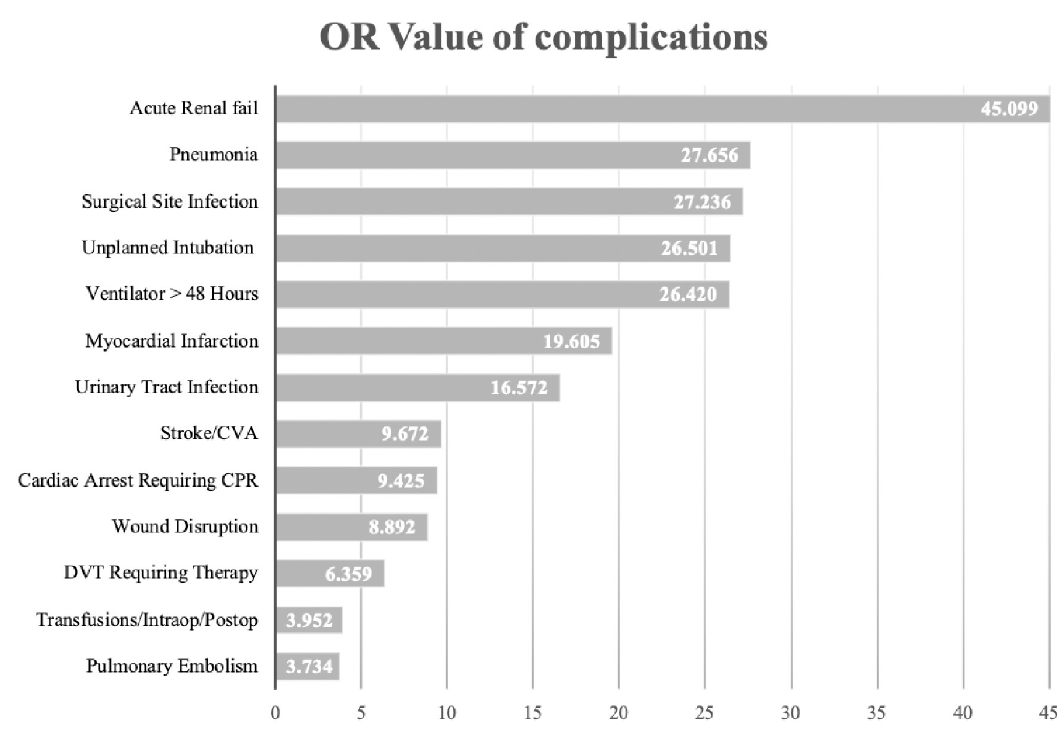
Fig 1. Complications related to S/SS (all p values < 0.001), the abscissa shows the OR value.